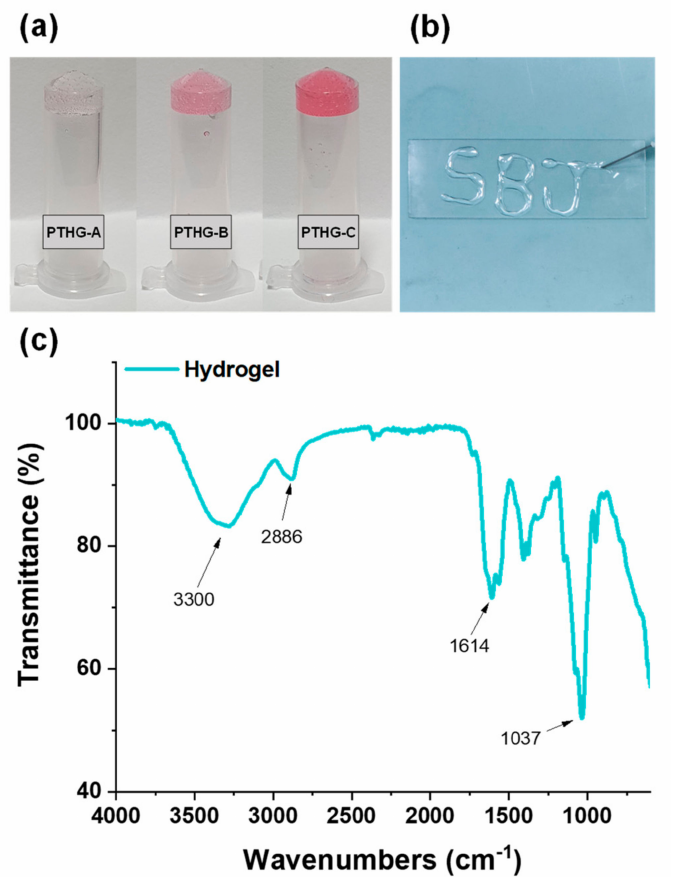
Figure 3. Prepared hydrogels. ( a ) Photographs of hydrogels (from left to right, PTHG-A, PTHG-B, PTHG-C, respectively), ( b ) Photograph showing injectability of hydrogel (PTHG-B), and ( c ) FTIR spectrum of